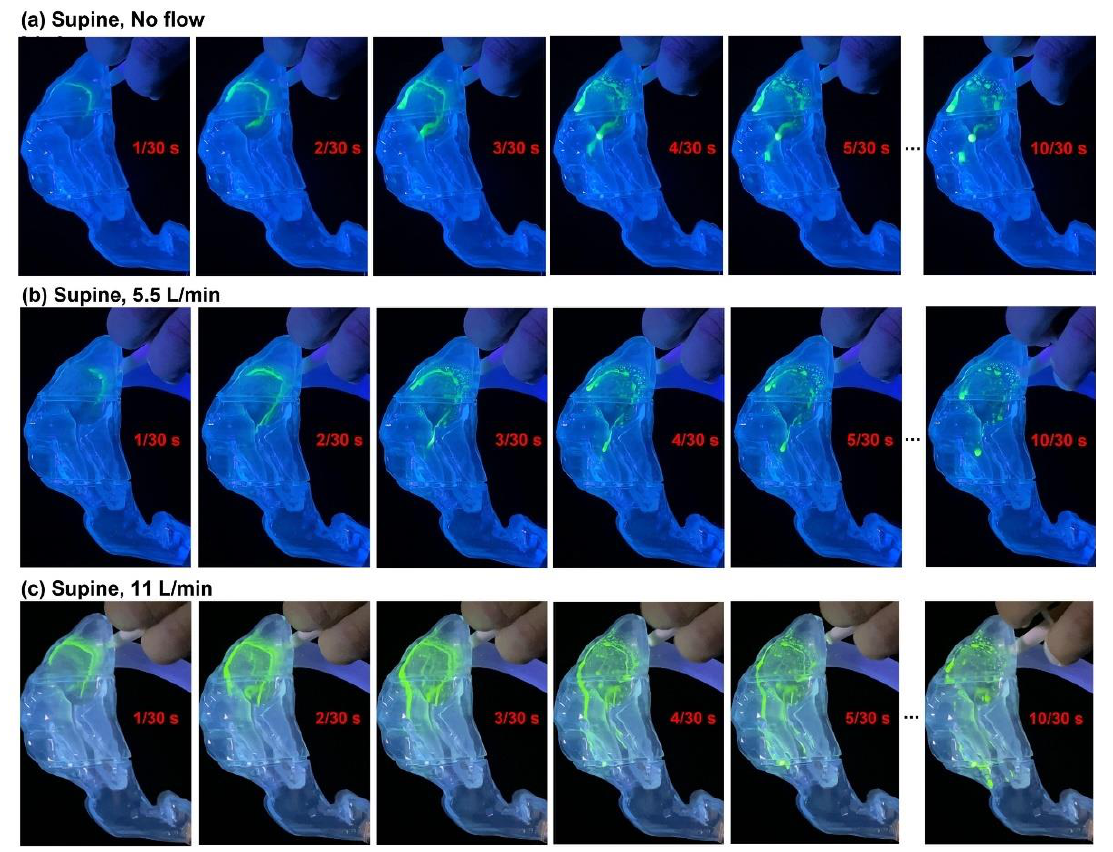
Figure 5. Liquid film translocation vs. time after administration using bidirectional delivery mode in a supine position under varying respiration flow rates: ( a ) no flow, ( b ) 5.5 L/min, and ( c ) 11 L/min.